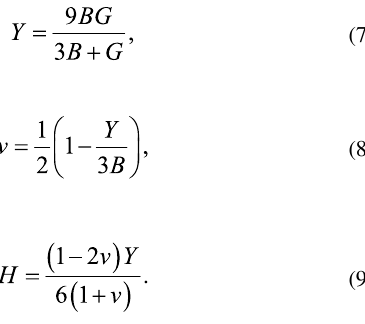
where S ij is the compliance tensor and S ij = C ij − 1 ; C ij are the elastic constants. Voigt and Reuss values provide the theoreti- cal upper- and lower-bound on mechanical properties using the axial loading and transverse loading models, respectively.